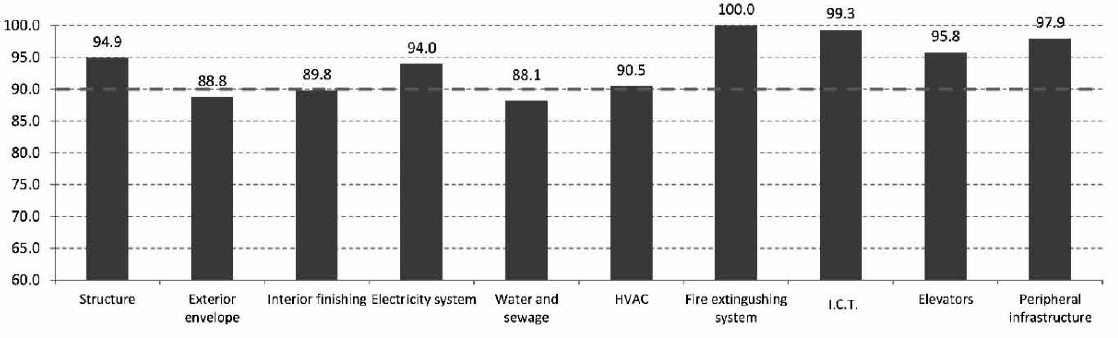
Fig. 5. Mean value of performance of each building’s system in the clinic